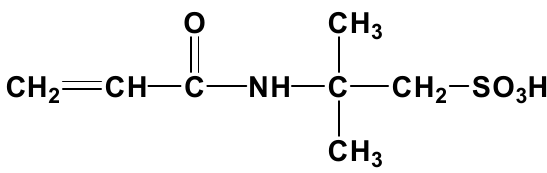
Figure 2. The structural characteristics of AMPS-AM.